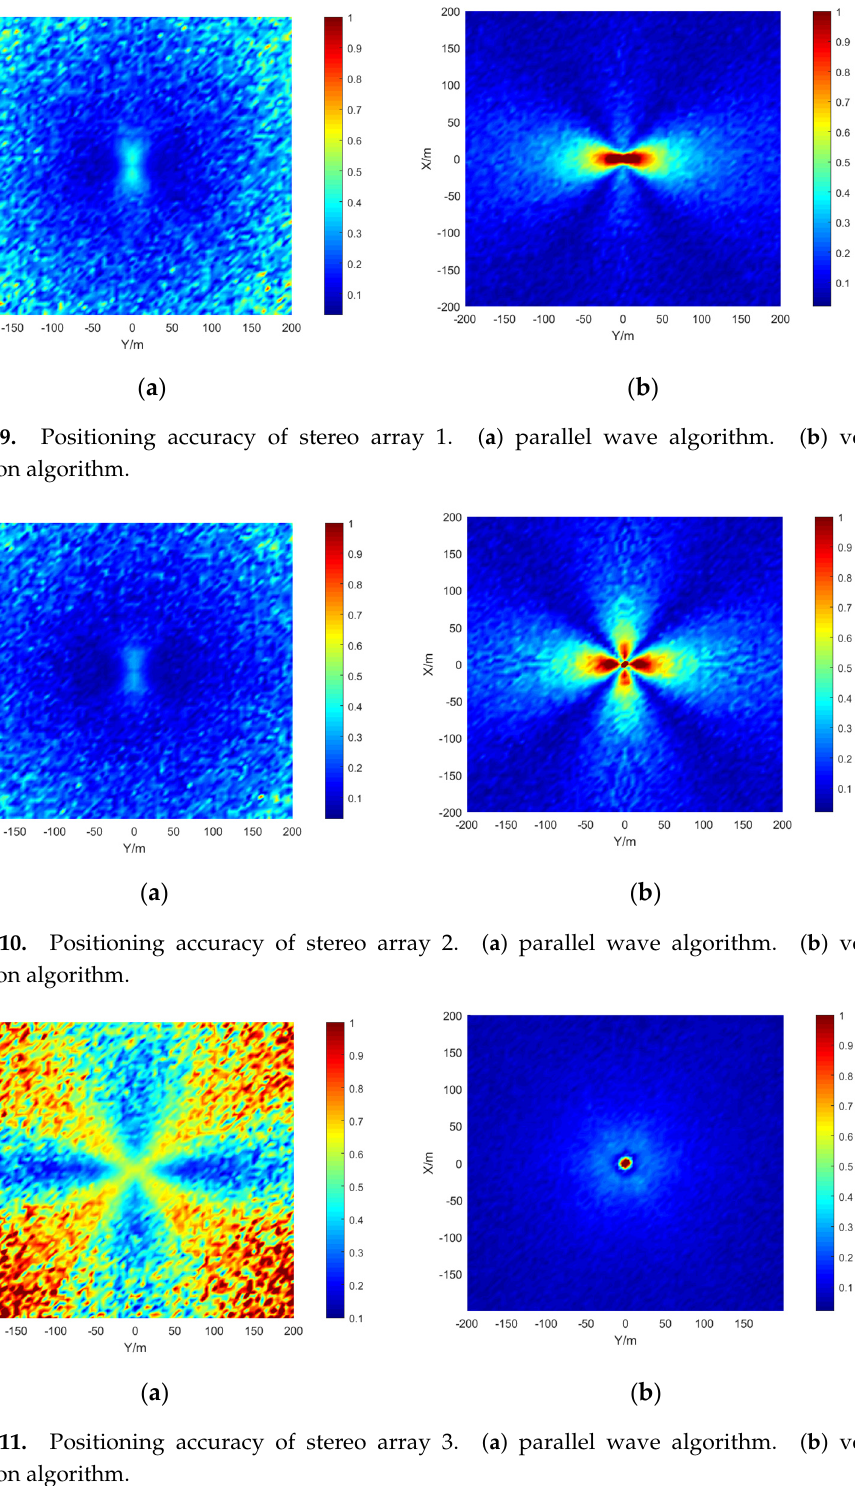
Figure 11. Positioning accuracy of stereo array 3. ( a )parallel wave algorithm ( b )vector projection algorithm.